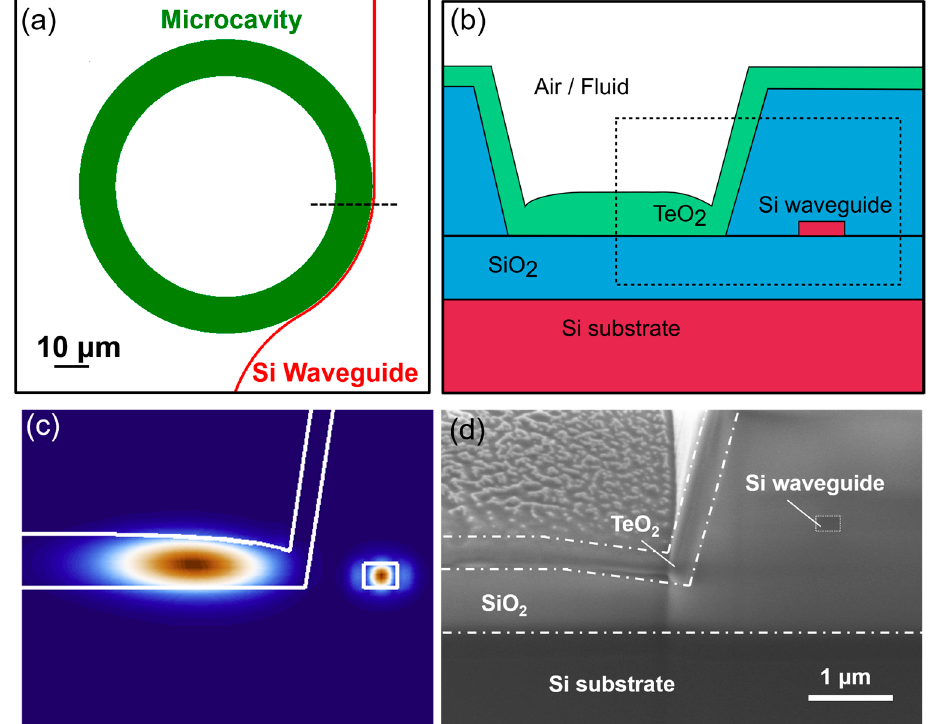
Figure 1. ( a ) Top view drawing of the resonator sensor showing the pulley-coupled silicon bus waveguide (red) and the TeO 2 microcavity (green). ( b ) Cross-section schematic of the device through the section indicated by the dashed line in (a), showing the silicon bus waveguide and the TeO 2 resonator layer coated into the trench. ( c ) Calculated fundamental transverse electric (TE) polarized electric field mode profiles for the TeO 2 resonator and silicon bus waveguide in the region indicated by the dashed line in (b). ( d ) Focused ion beam (FIB) scanning electron microscope (SEM) cross-section image of a fabricated device showing the realized structure.